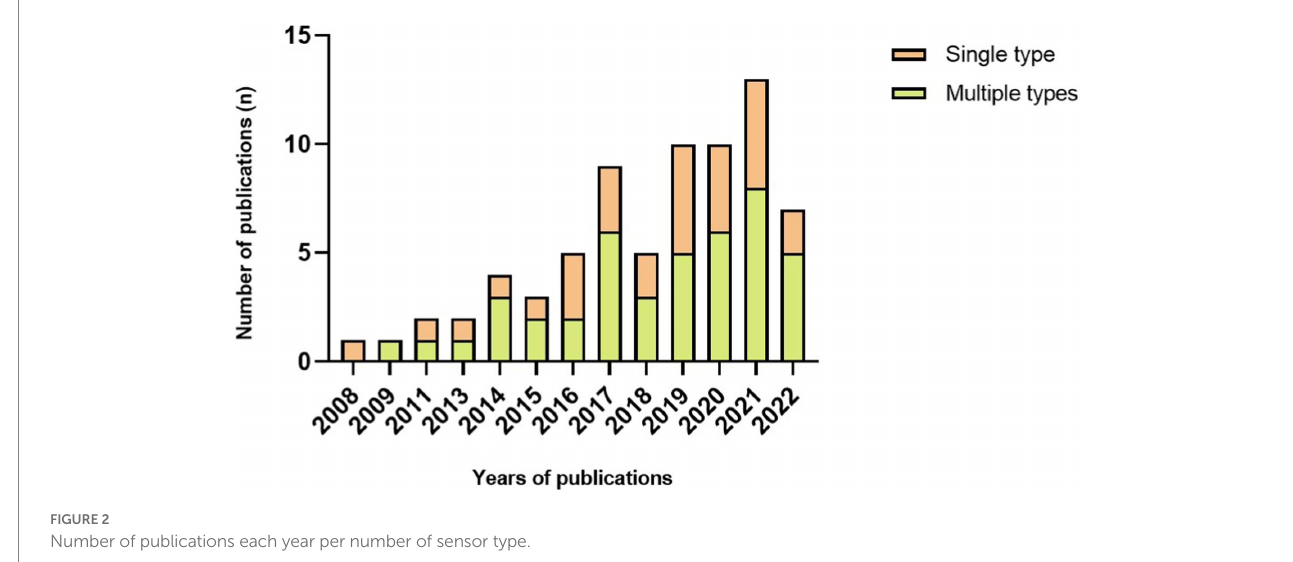
FIGURE 2 Number of publications each year per number of sensor type.